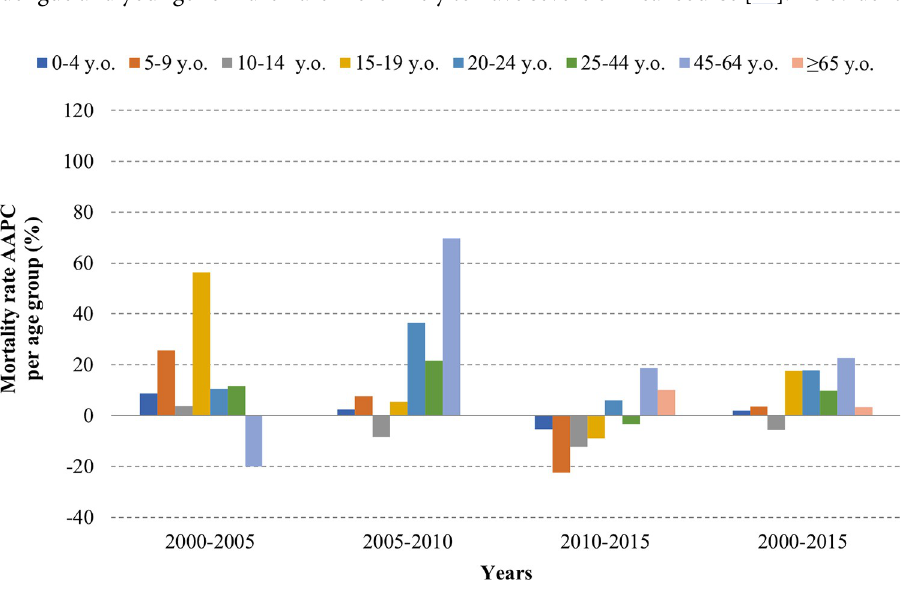
Fig 4. Average annual percent change in dengue mortality per age